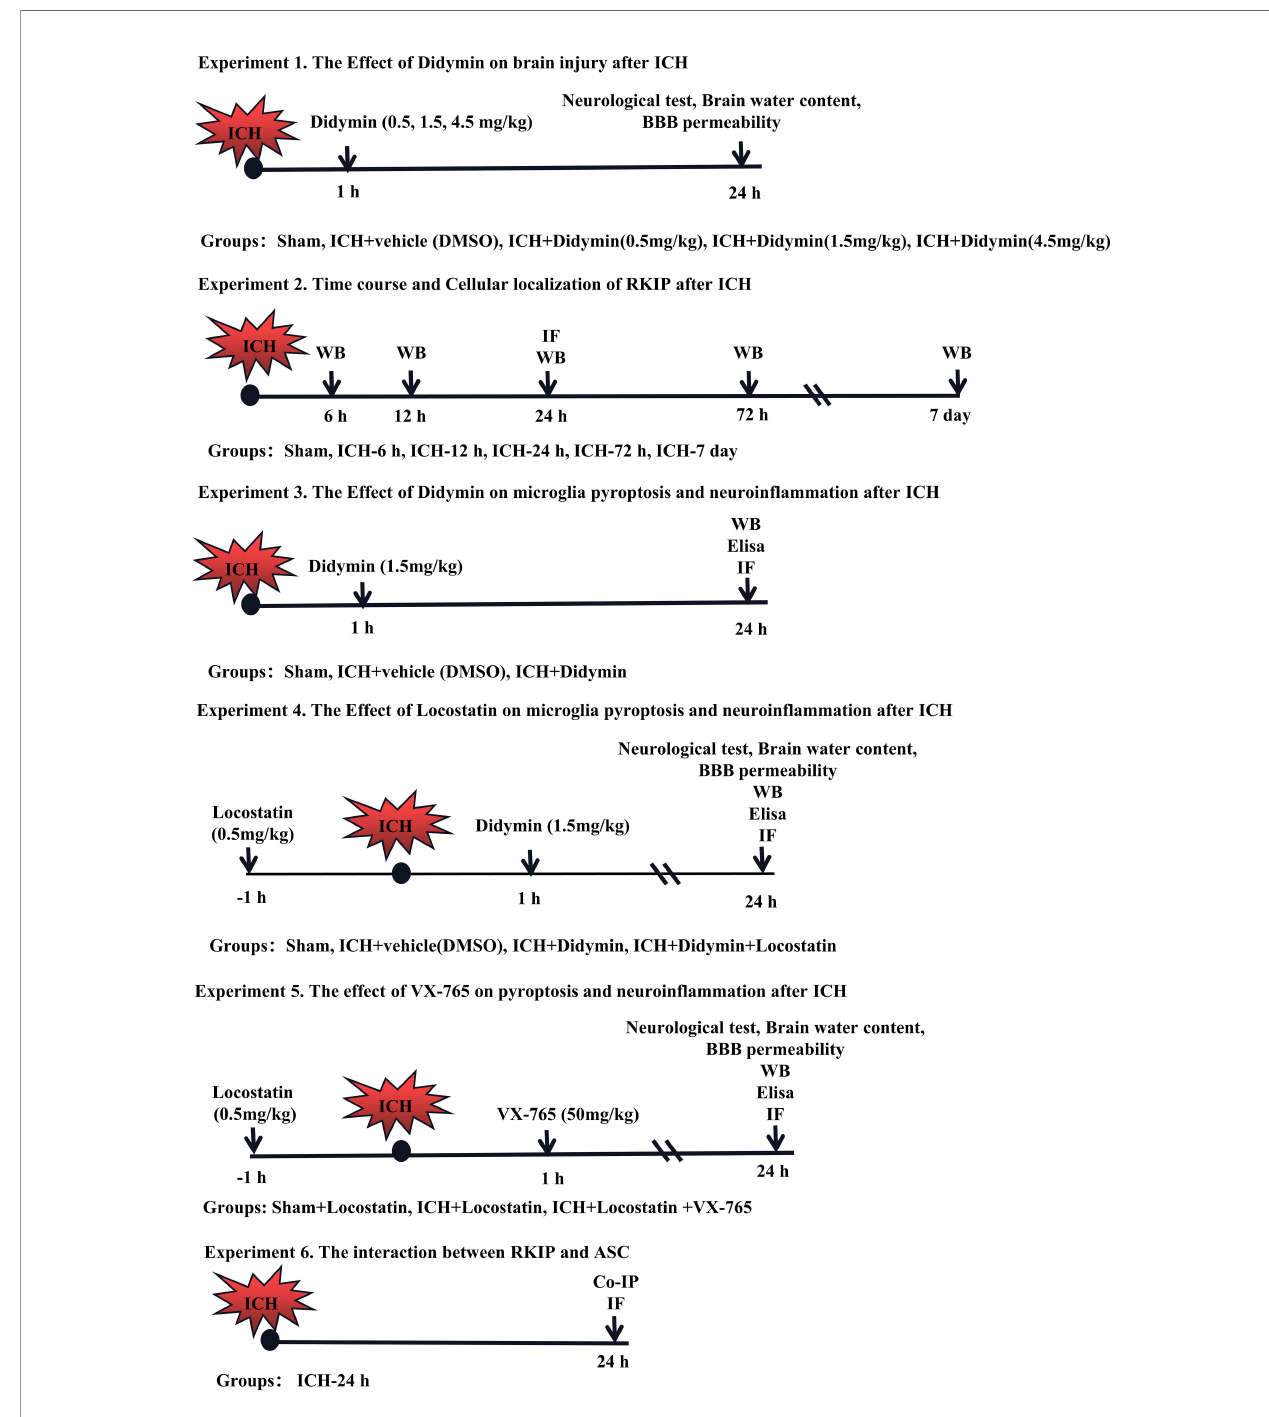
FIGURE 1 | Experimental design and animal groups. Co-IP, co-immunoprecipitation. DMSO, dimethyl sulfoxide. Elisa, enzyme-linked immunosorbent assay. ICH, intracerebral hemorrhage. IF staining, immuno fl uorescence staining. WB, Western